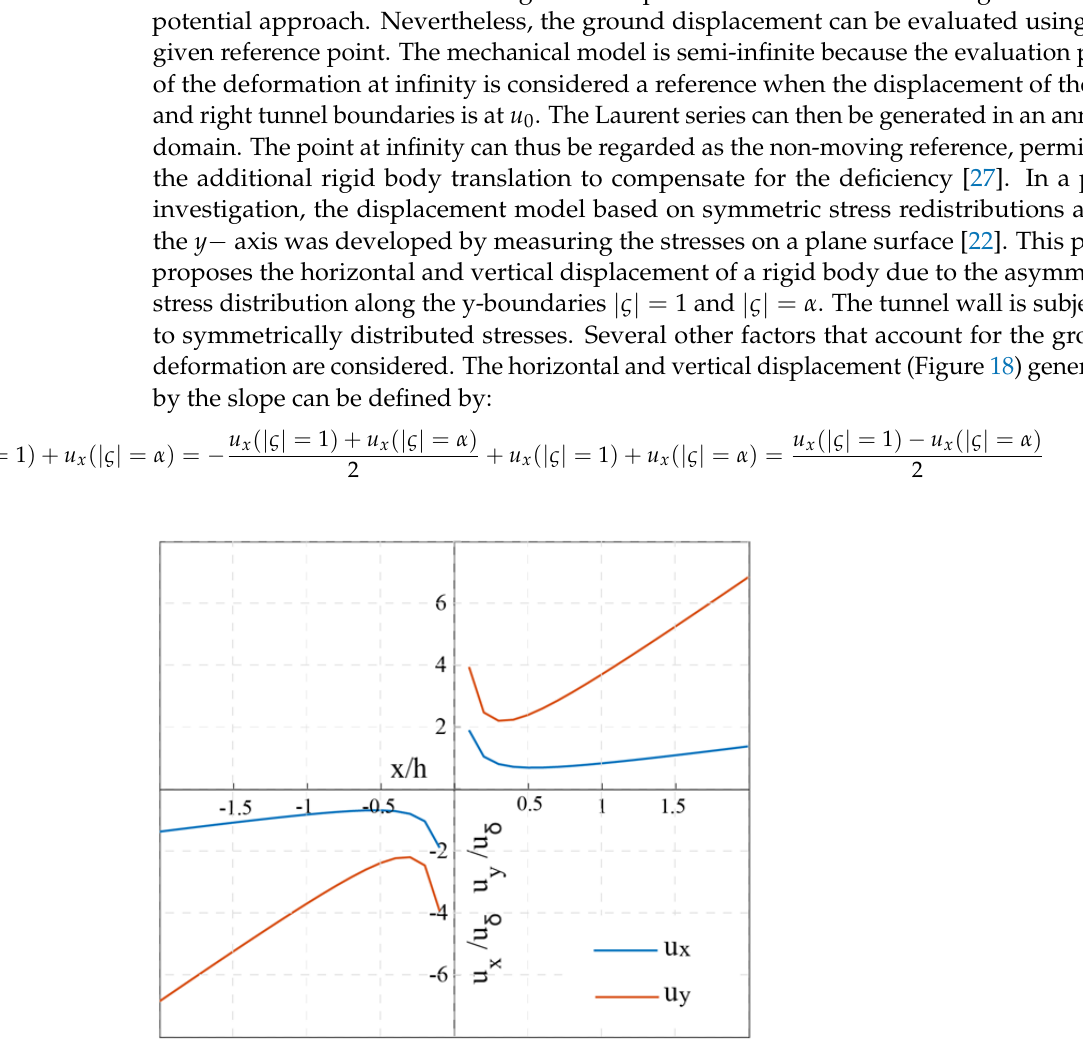
Figure 18. Horizontal and vertical displacement given by ovalization.